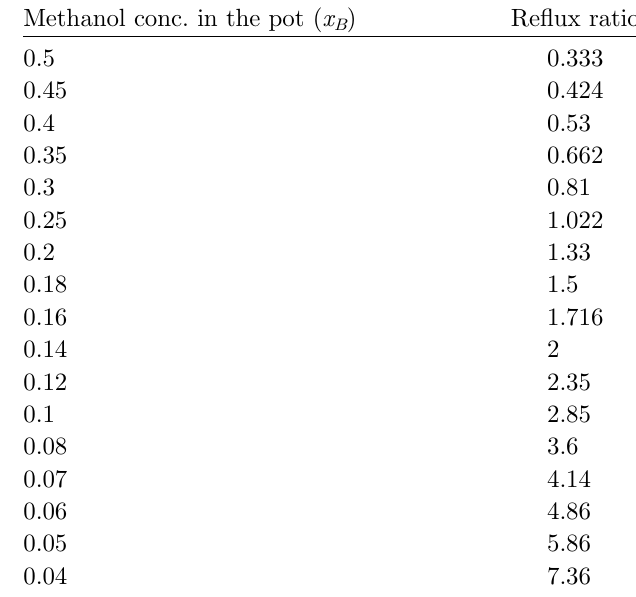
Table 1. Value of the re fl ux ratio at a speci fi c time that keeps the distillate concentration constant at